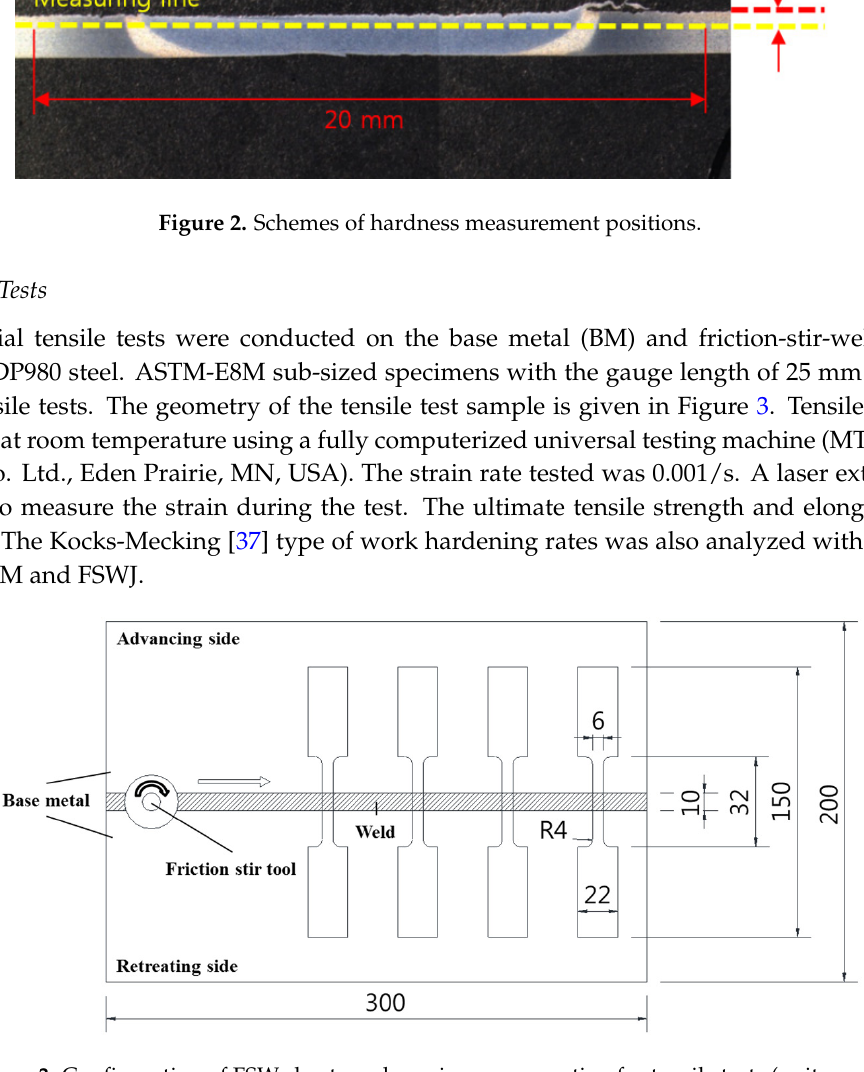
Figure 3. Configuration of FSW sheets and specimen preparation for tensile tests (units: mm).